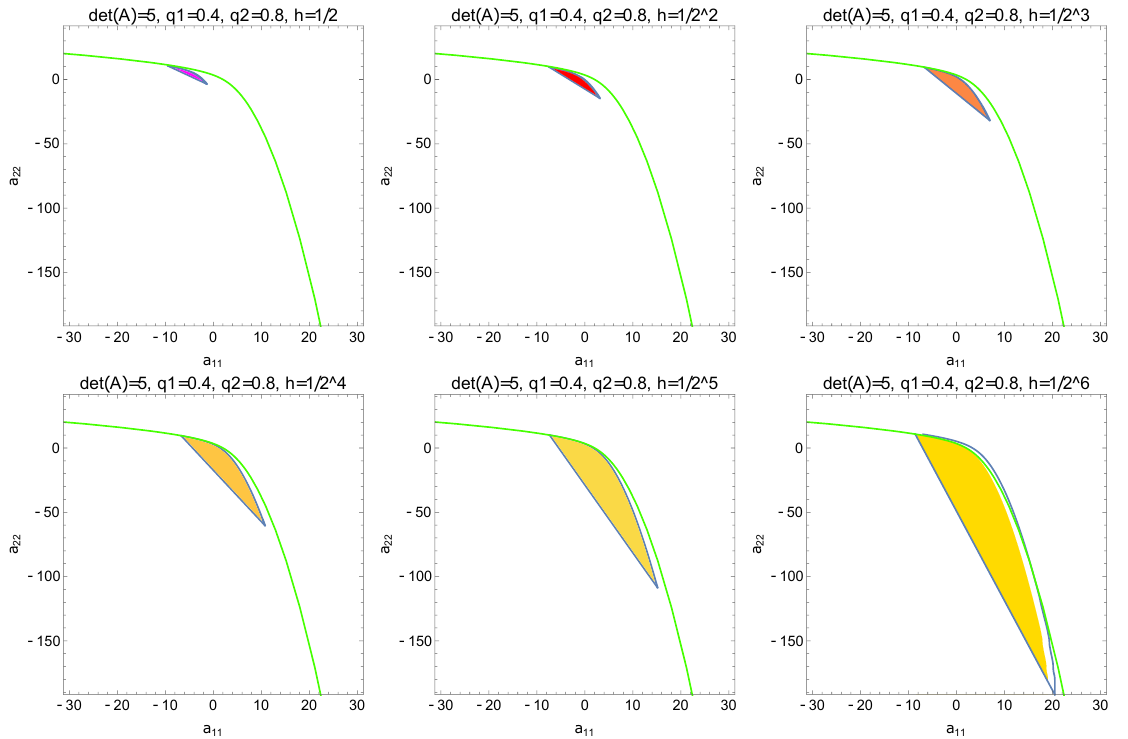
Figure 1. Stability regions S ( δ , q 1 , q 2 , h ) in the ( a 11 , a 22 ) -plane, for several values of the discretization step h . The boundary of the stability region corresponding to the continuous-time counterpart [8] is represented by green